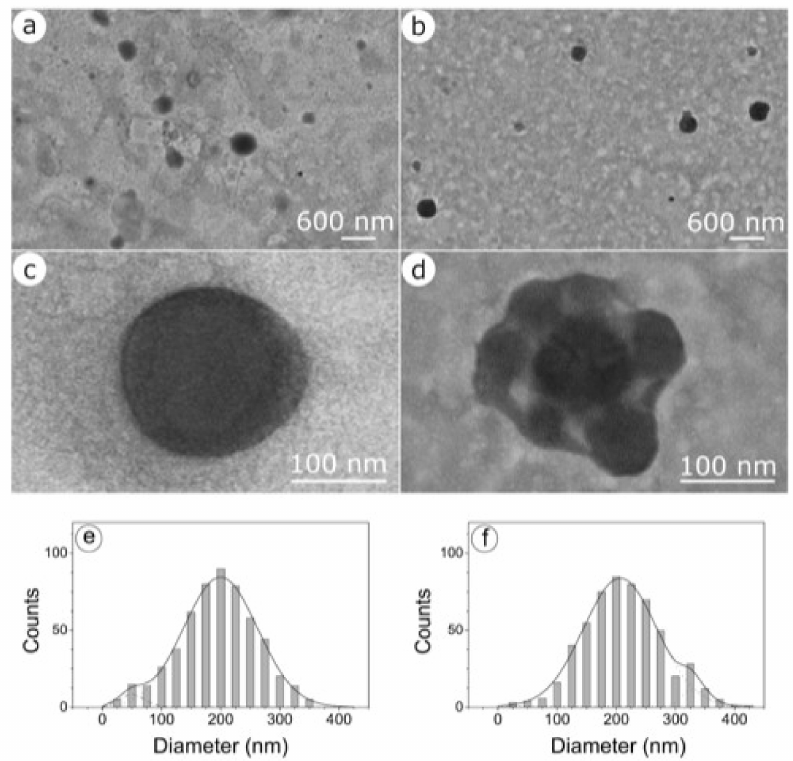
Figure 2. TEM microphotographs of DA-SLN (panel ( a , c , e )) and GSE/DA SLN (panel ( b , d , f )). Moreover, information on the solid state of the SLN prepared was obtained by FT-IR spectroscopy and Differential Scanning Calorimetry (DSC). In Figure 3, the FT–IR spectra of pure DA, pure GSE, DA-SLN, GSE-SLN and GSE/DA-SLN as well as the thermograms of pure DA, pure GSE, DA-SLN and GSE/DA-SLN are reported.